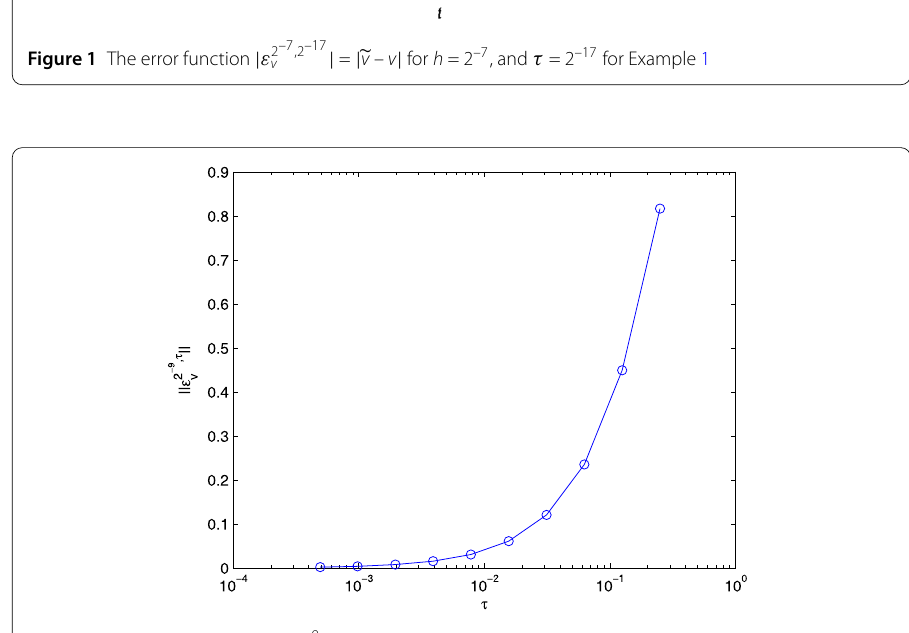
2–9, τ (cid:7) for h = 2 –9 , with respect to τ of Example v